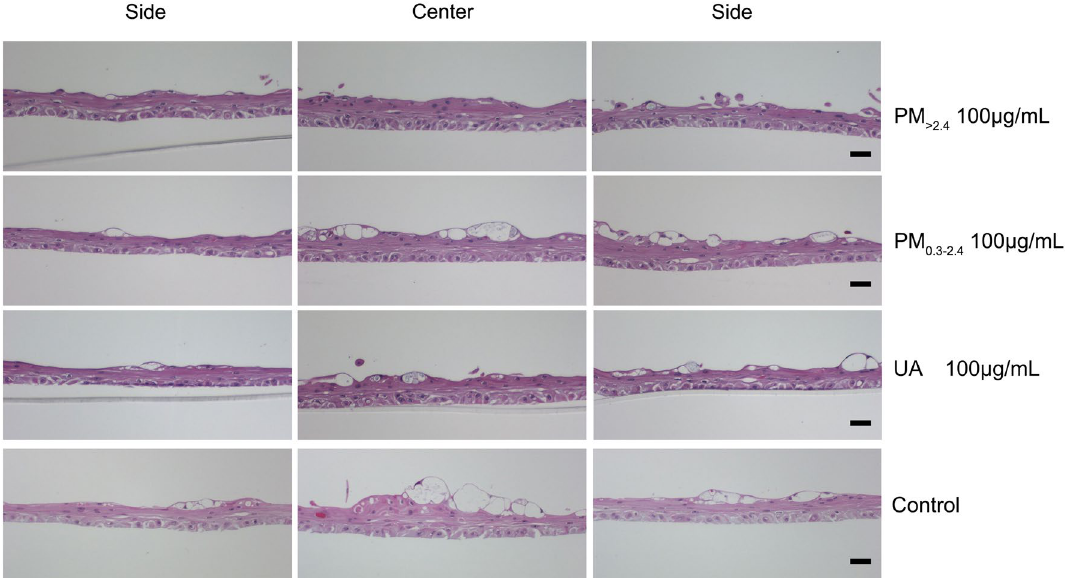
Figure 5. Representative histological images (hematoxylin and eosin staining, ×100 magnification, both sides and center of each model). Reconstructed human corneal epithelial tissues after 24-h exposure to PM >2.4 100 µg/ mL, PM 0.3–2.4 100 µg/mL, UA 100 µg/mL, and control. The length of the bar in each photograph is 50 µm. PM > 2.4 particle matter larger than 2.4 µm, PM 0.3–2.4 particle matter 0.3–2.4 µm, UA urban